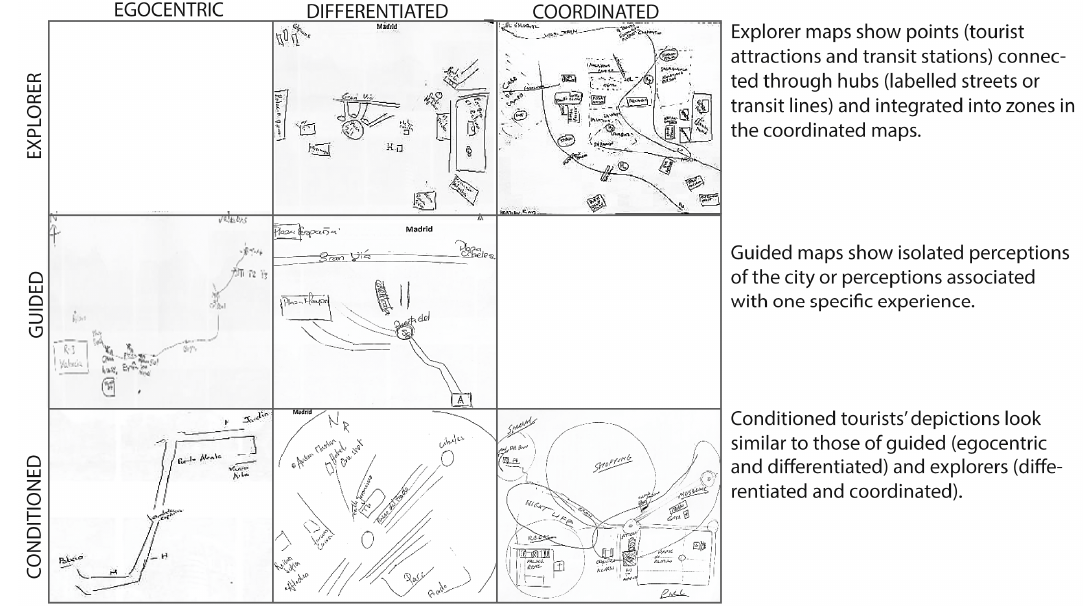
Figure 9. Sketches classified by type of tourist and reference system.